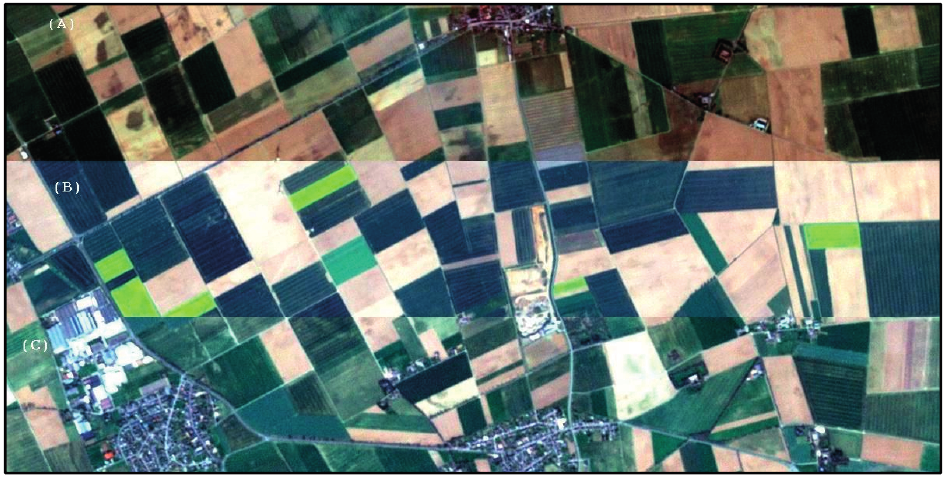
Figure 4. Part of the standard L3A RapidEye image from 2 April 2011 ( A ); The reference image dated 24 April 2011 ( B ); IR-MAD processed image ( C ). RGB band combinations are